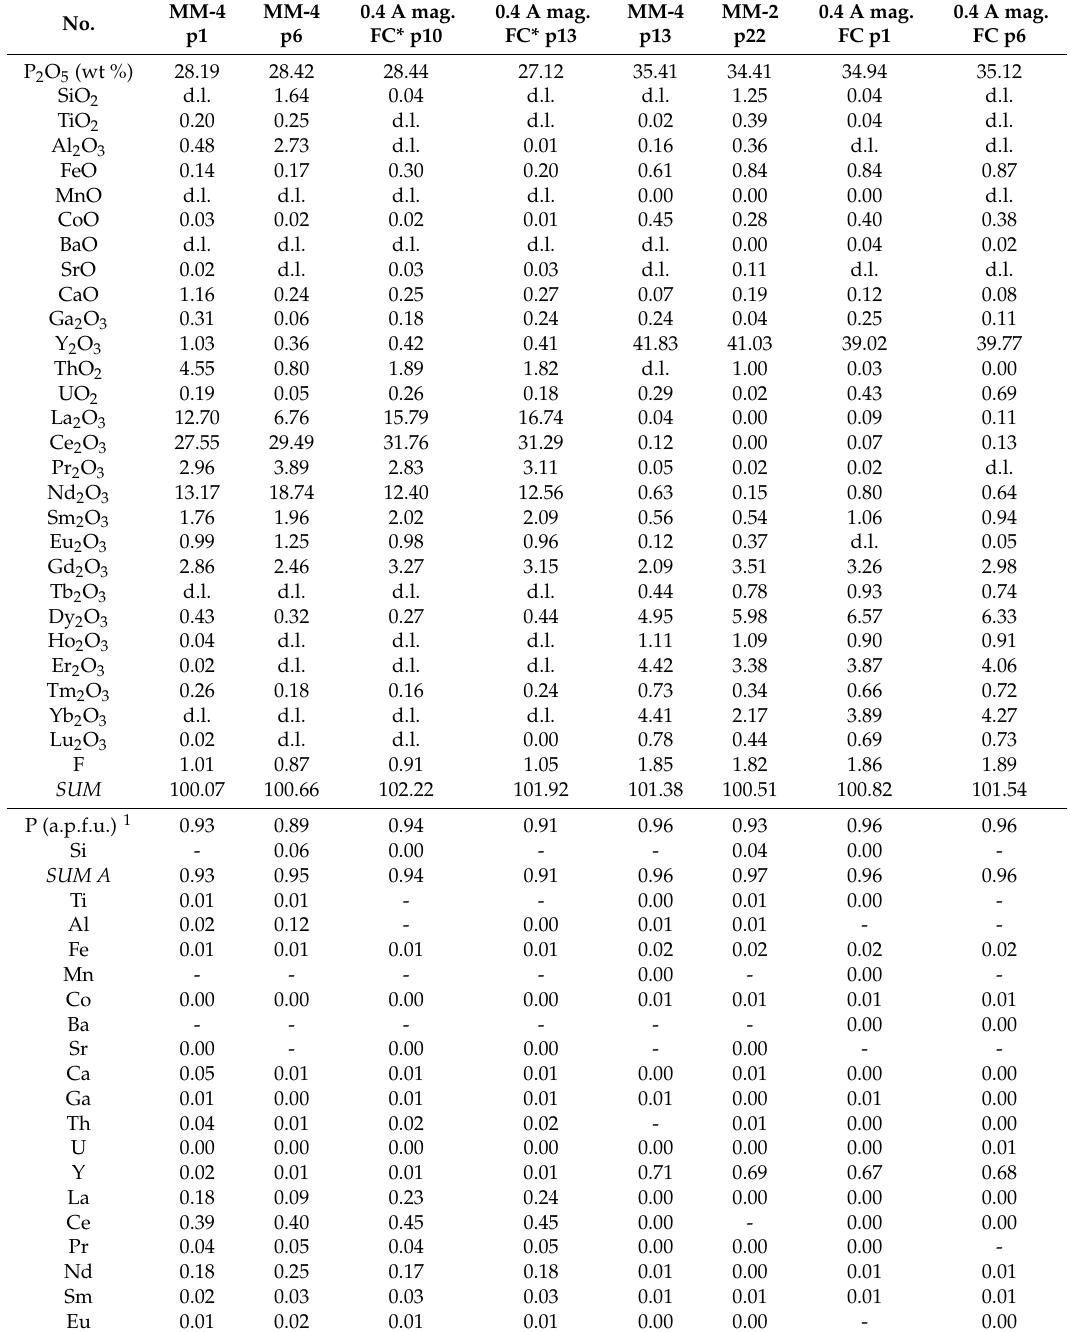
Table 4. Representative EPMA analyses of monazite-(Ce) (left) and xenotime-(Y) (right) grains in heavy mineral concentrates and thin sections of the bauxitic samples of the CCR.